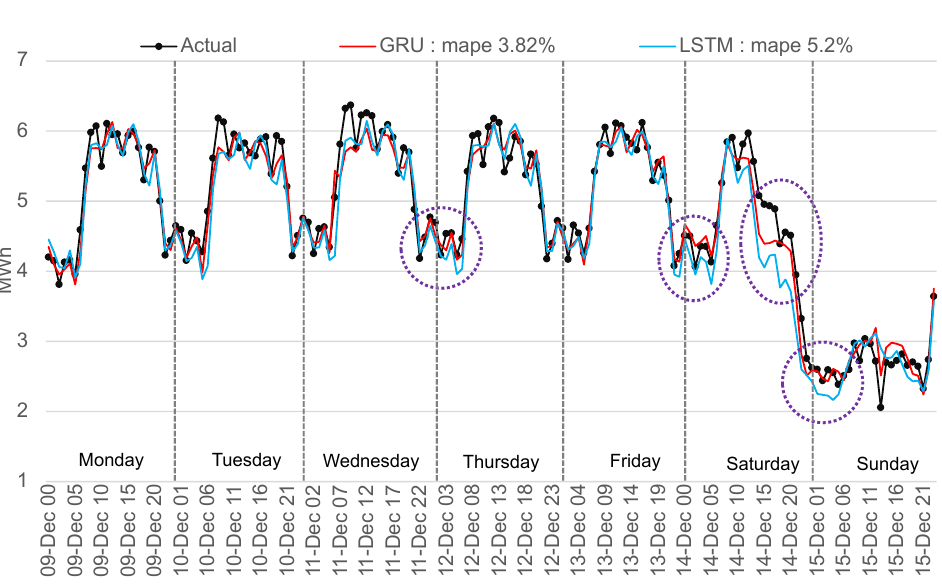
Figure 19. Comparison of actual with forecasted consumption—GRU. The GRU method forecasted with the lowest error the entire test period and confirmed the best performance for the unfavorable period from 27 November 2019 (Wednesday) to 3 December 2019 (Tuesday) with 5.7% MAPE. Another comparison is presented in Figure 20 for a normal week (from 9 December 2019 to 15 December 2019) to highlight the differences between the best-two methods implemented. The GRU forecast outperforms the LSTM by 26.59% with 3.82% MAPE, while LSTM scored a MAPE of 5.2%. For Saturday, it can be observed that the algorithms forecasted a much lower value of consumption, a situation explainable by the influence of the weekend from previous analysis with the legal holidays.